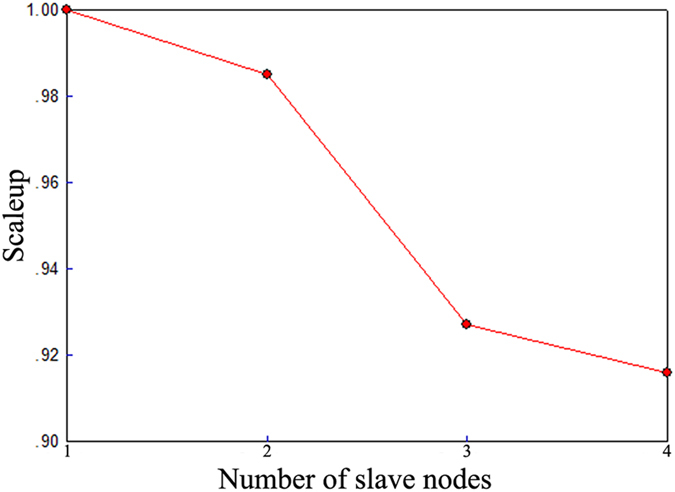
Scaleup comparison.